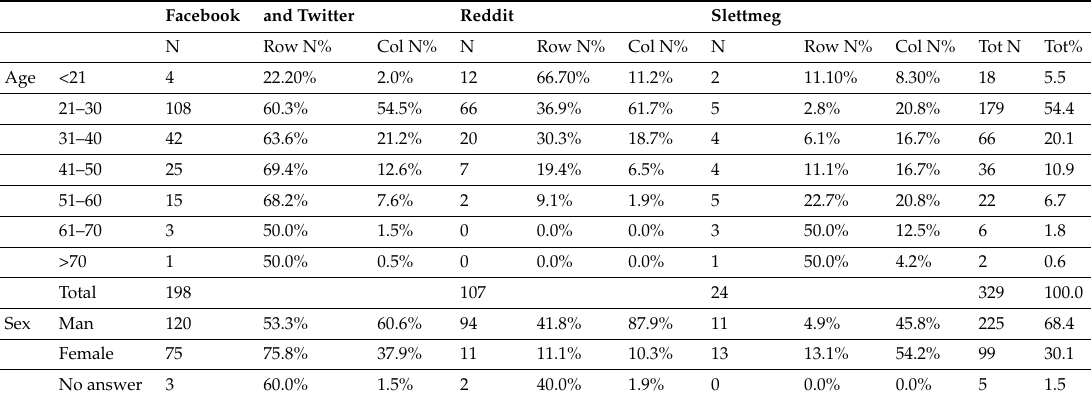
Table 3. Age and sex distributions sorted on recruitment